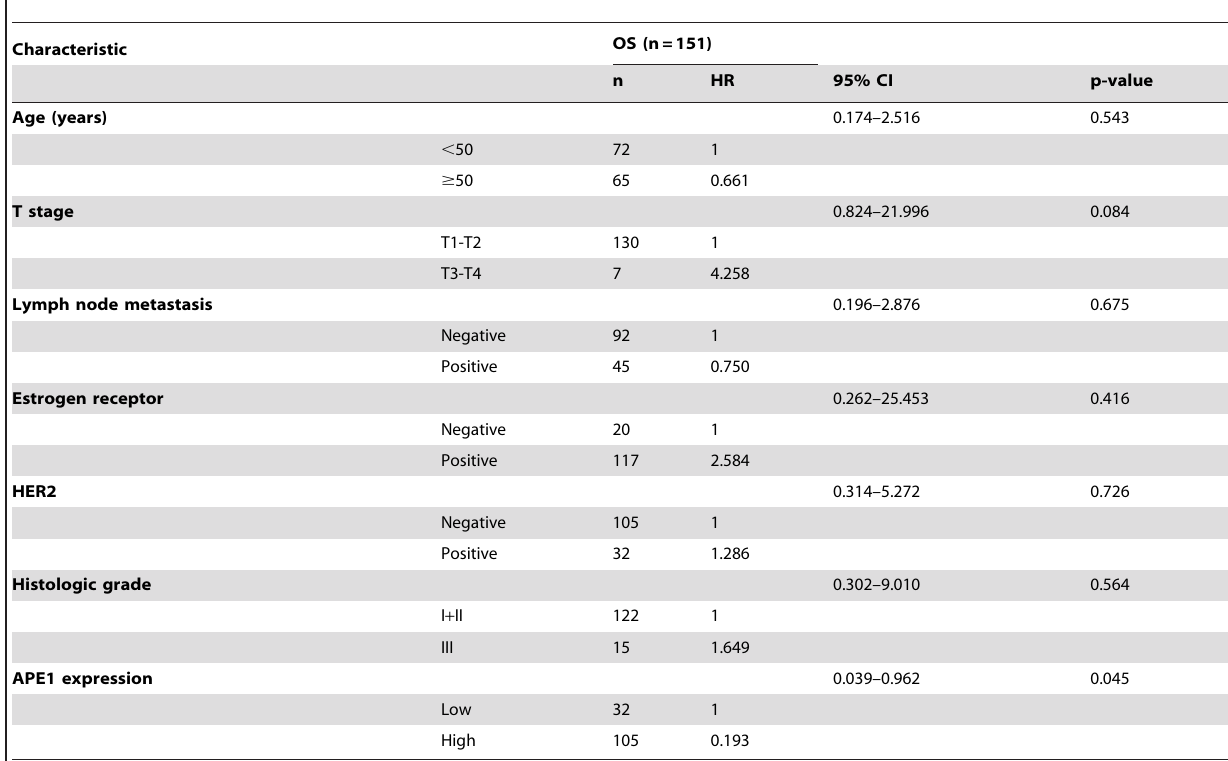
Table 2. Cox regression analysis of nuclear APE1 expression on OS in invasive breast cancer defined by the Ki-67 low-level expression